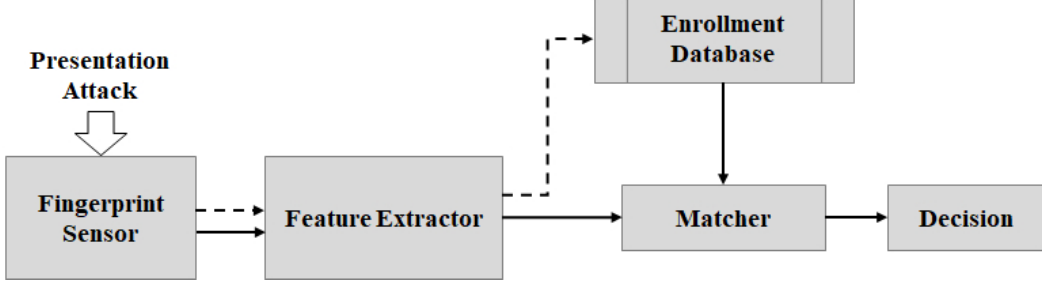
Figure 1. A general fingerprint recognition system. Dashed arrows ( (cid:57)(cid:57)(cid:75) ) indicate the enrollment process; solid arrows ( → ) indicate the recognition